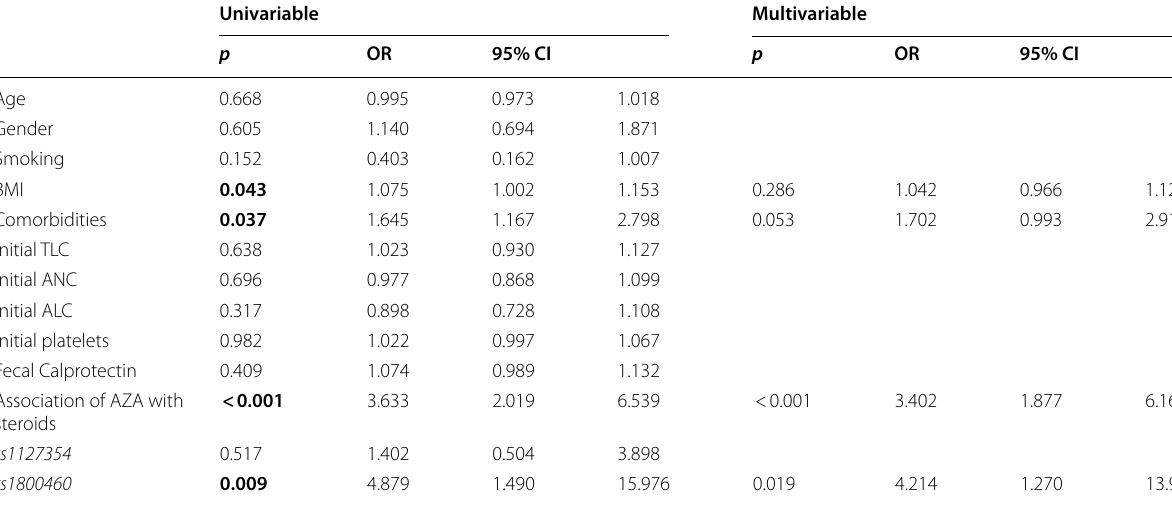
OR odds ratio; CI confidence interval Bold values indicate significant results <